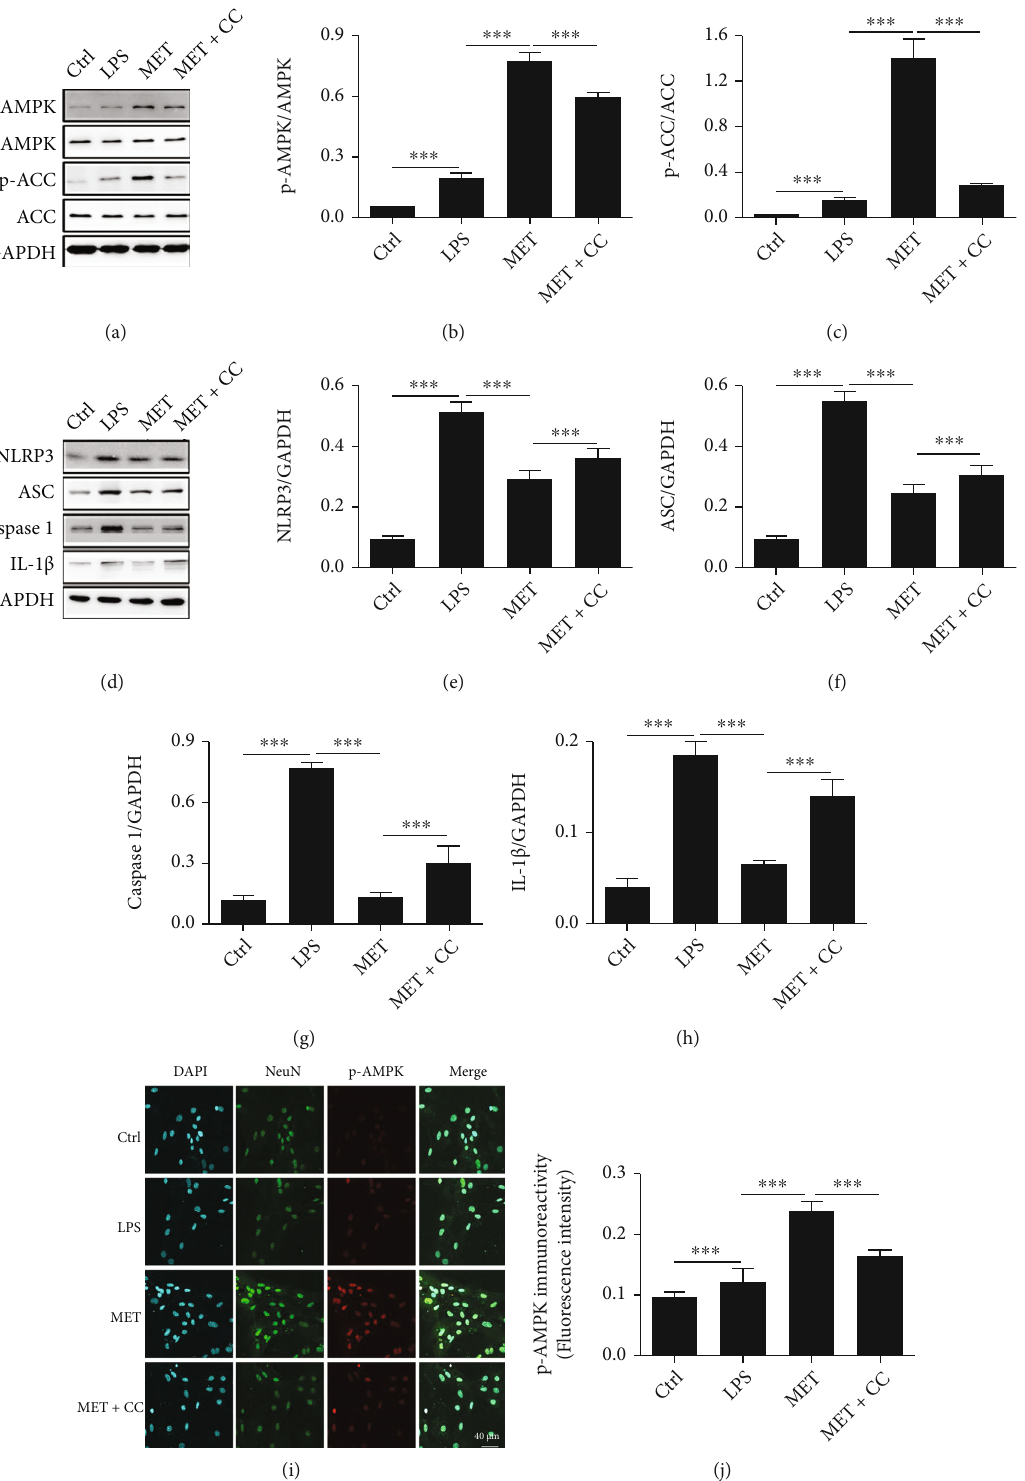
Figure 2: Metformin activates the AMPK/NLRP3 signaling pathway in spinal cord neurons. (a – c) Representative Western blots and quanti fi cation data of the levels of p-AMPK and p-ACC in the spinal cord neurons from each group. All data represented the mean ± SD , ∗∗∗ P < 0 : 001 , n = 3 . (d – h) Representative Western blots and quanti fi cation data of the expression of NLRP3, ASC, Caspase 1, and IL- 1 β in the spinal cord neurons from each group. All data represent the mean ± SD , ∗∗∗ P < 0 : 001 , n = 3 . (i, j) Immuno fl uorescence examination was utilized to recognize the staining power of antibodies focusing on NeuN and p-AMPK. Scale bars represent 40 μ m. ∗∗∗ P < 0 : 001 , n = 3